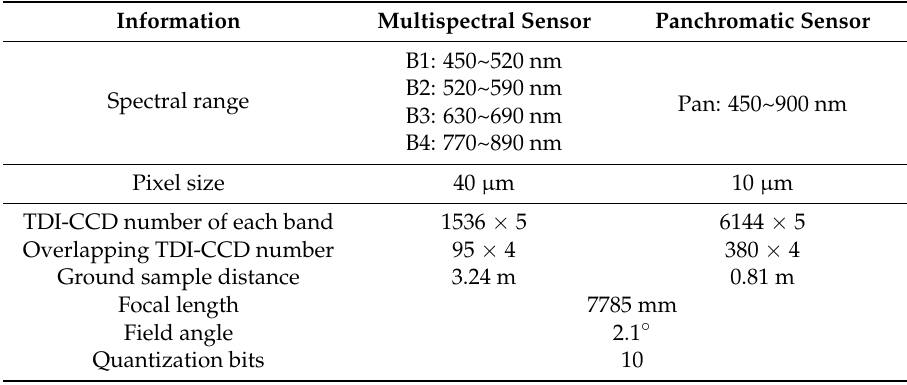
Table 1. Information for the single camera on the GF2